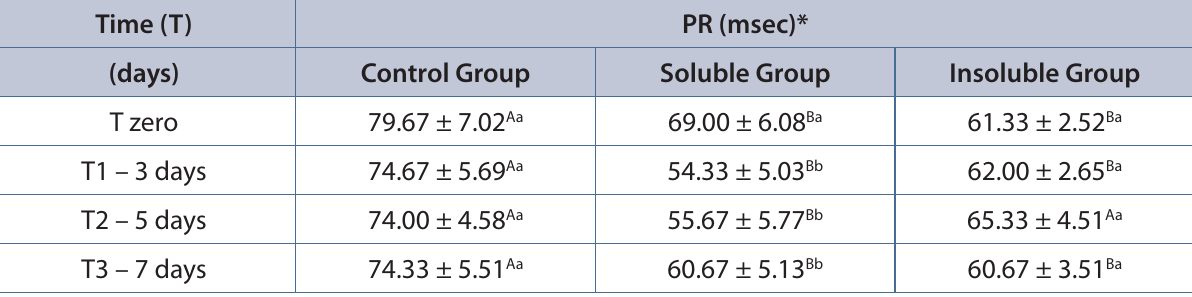
Table 4. Mean durations of PR interval (msec) in rabbits submitted to gavage procedure with ultra-pure water (CG), water-soluble A. rigida extract (SG) and water-insoluble A. rigida extract (IG) at different times